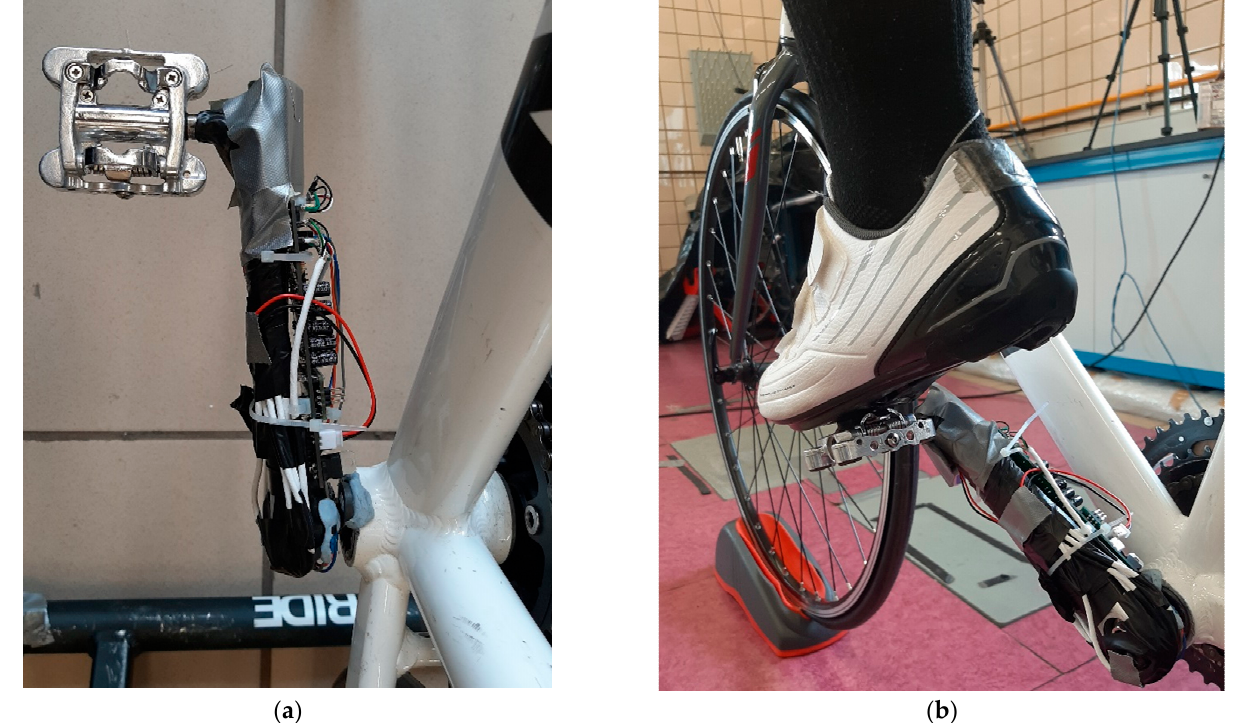
Figure 7. Measurement equipment located on the bike. ( a ) Location. ( b ) Pedalling test.